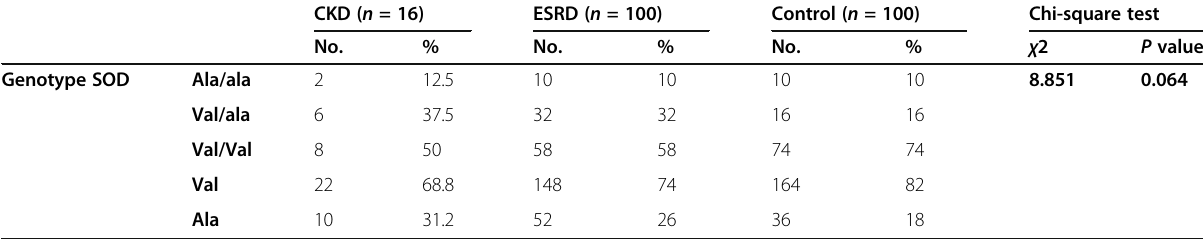
Table 2 Distribution of MnSOD Val16Ala polymorphism in cases and controls